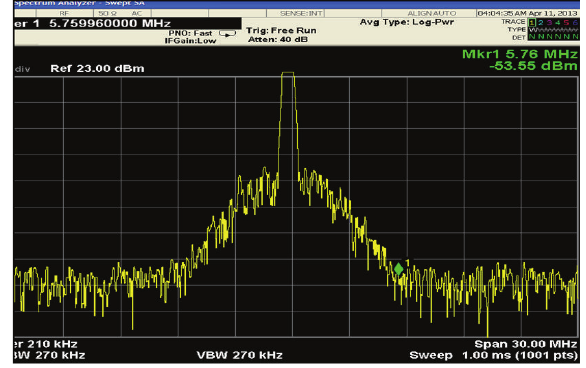
Figure 6: 4th degree Chi-square power distribution Swerling model.